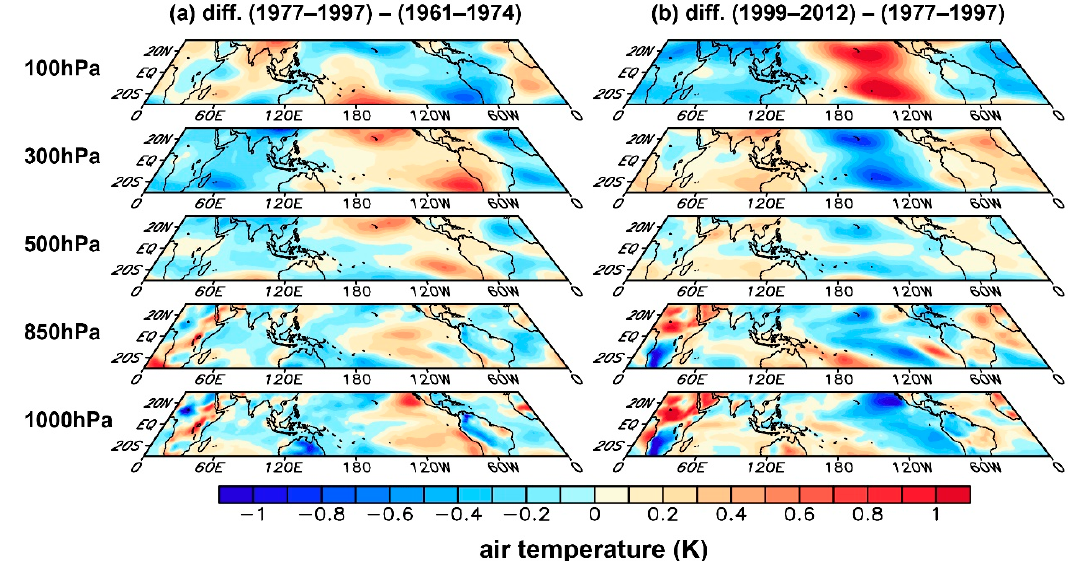
Figure 9. Differences in the inhomogeneous air temperature (K) at low latitudes (30° S–30° N) between ( a ) the periods 1961–1974 and 1977–1997 and ( b ) the periods 1977–1997 and 1999–2012 for layers 1000, 850, 500, 300, and 100 hPa.